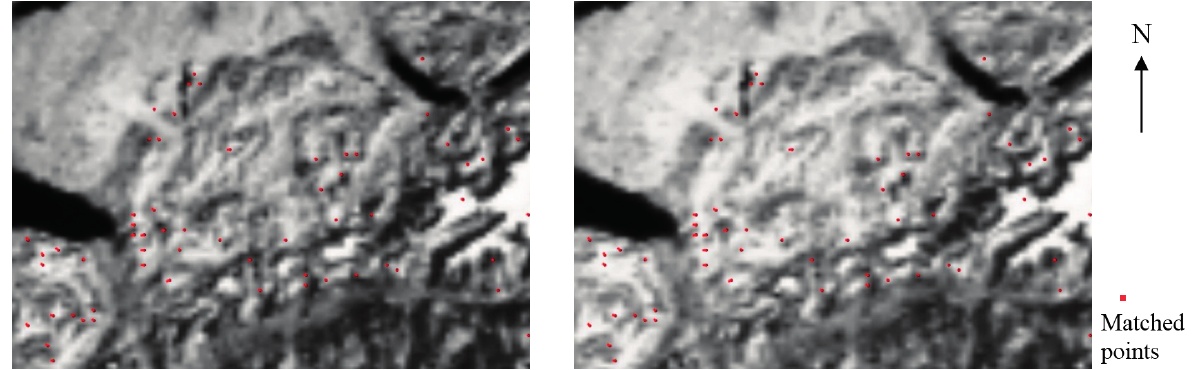
Figure 2. AVHRR Band-2 orthoimages acquired on 10 July 2008 from Metop-A ( left ) at 09:36 and NOAA-17 ( right ) at 09:45. The matched points between the orthoimages are shown in